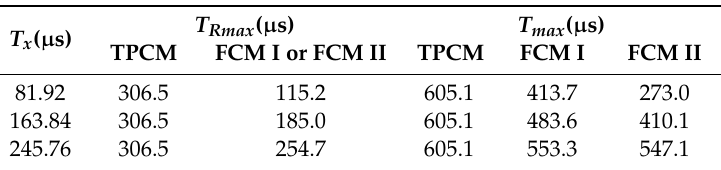
Table 1. Measurement times for T Rmax and T max as a function of T x and of the calibration method used. The Rmax value used was 7464.5 Ω